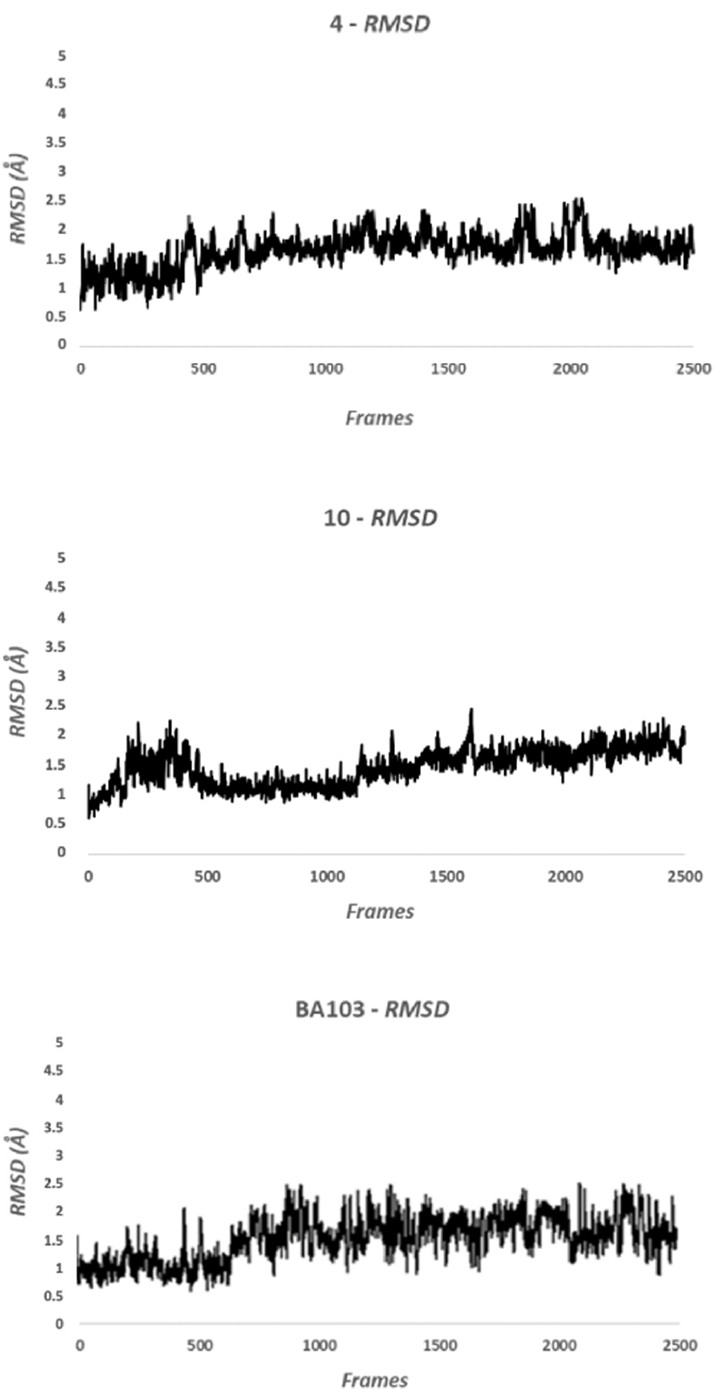
Figure 3. Root Mean Square Deviation of 4, 10, and BA103 during the Molecular Dynamic simulations. Values below to 3Å indicating that compounds stably interact with residues that constitute the binding site for the whole simulation.